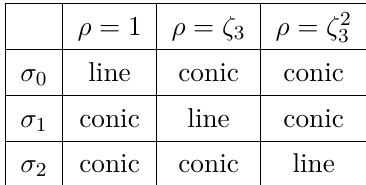
Table 3 . How the sections σ i meet the I 2 fibres in E 6 fibrations.